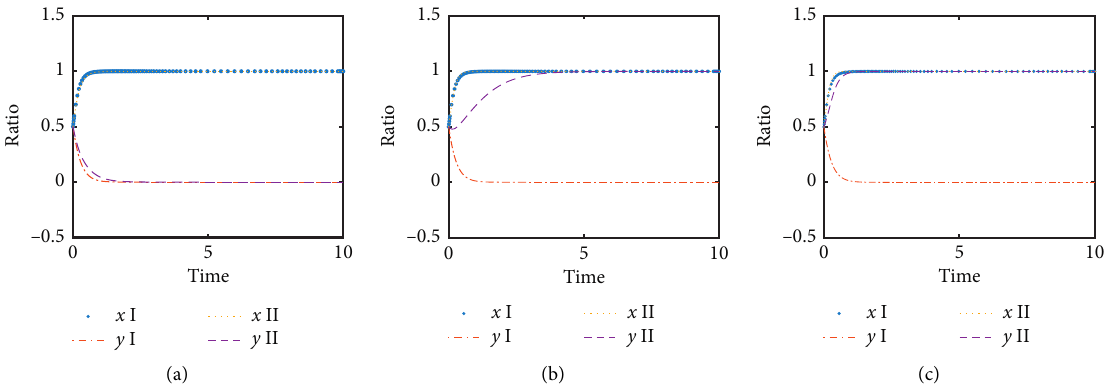
Figure 9: The influences of the incentive coefficient of knowledge sharing on the evolution system. (a) α (c) α g � 0 . 2 , α s �